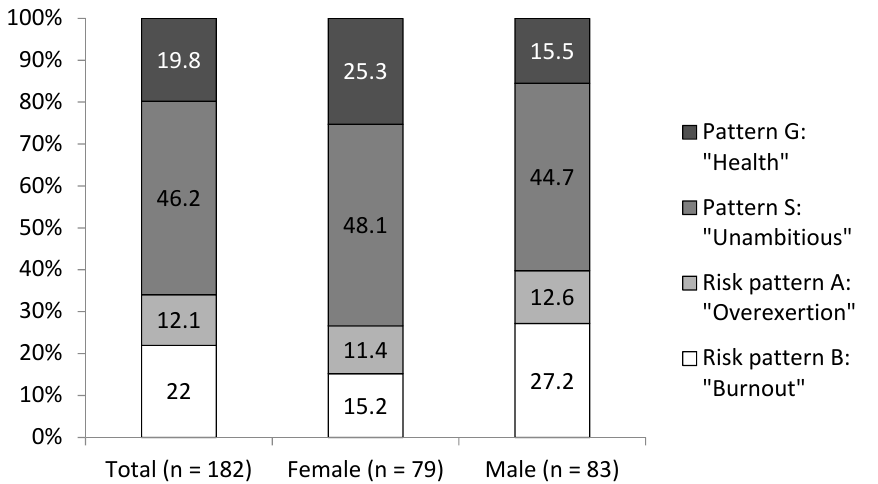
Figure 1. Distribution of work-related behavior and experience patterns in the financial services company’s employees.